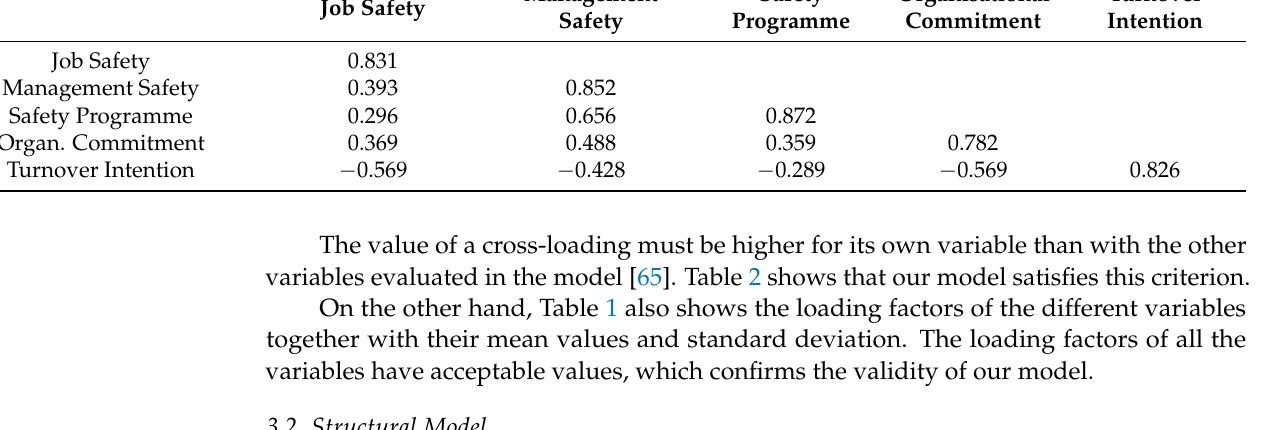
Table 2. Discriminant validity—Fornell–Larcker criterion.